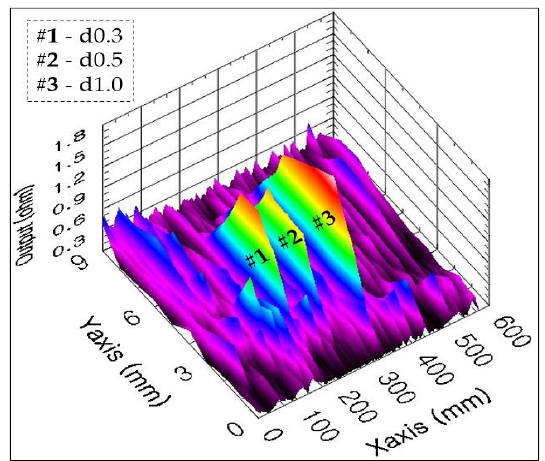
Figure 14. Cracks imaging obtained with 300 kHz.